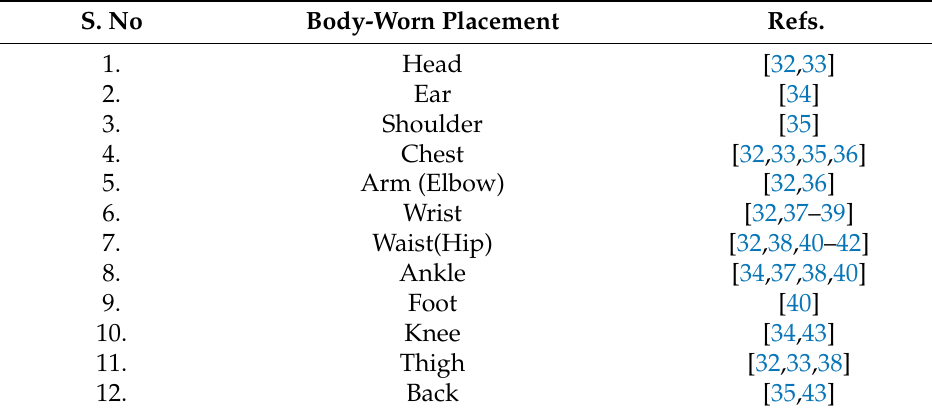
Table 1. Body-worn devices placement on-body for